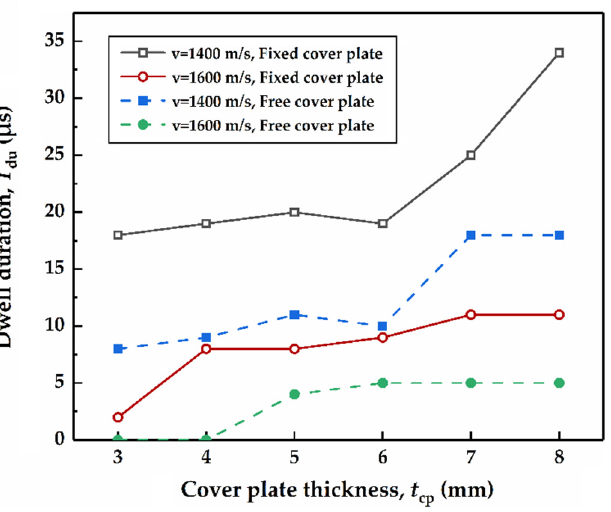
Figure 9. Simulated dwell duration in cases in which the impact velocities are 1400 m/s and 1600 m/s.